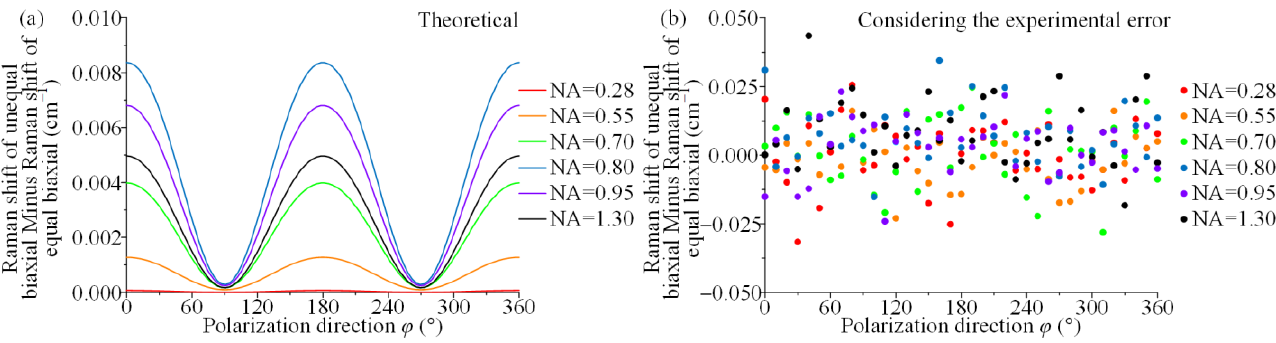
Figure 9. Difference in Raman shifts of the unequal biaxial and biaxial stress states of ( a ) theoretical and ( b ) introducing the random error in polarization direction and system.